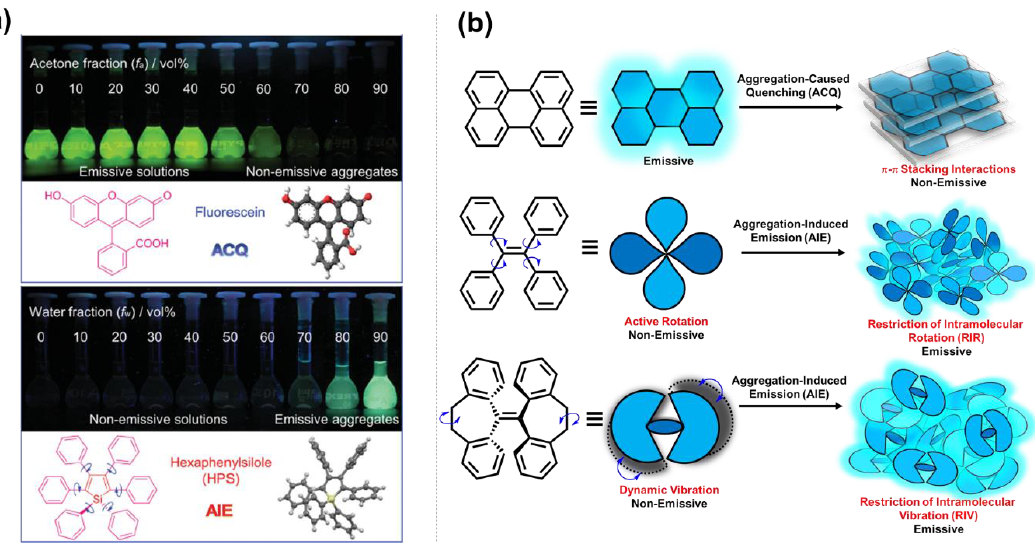
Figure 1. ( a ) Photographs showing the ACQ behaviour of fluorescein and AIE properties of HPS, in the mixture of water-miscible organic solvent and water. Reproduced with permission from [16].